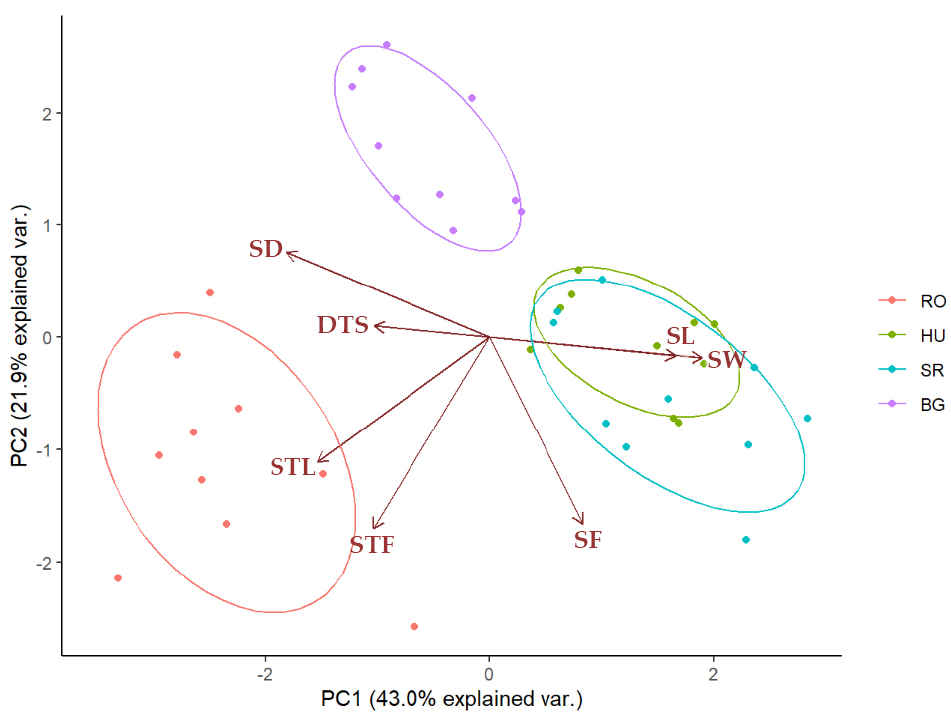
Figure 7. PCA biplot depicting Ilex aquifolium population clusters based on the first two principal components, i.e., PC1 and PC2, which accounted for 43.0% and 21.9%, respectively, of the total variation in all populations.